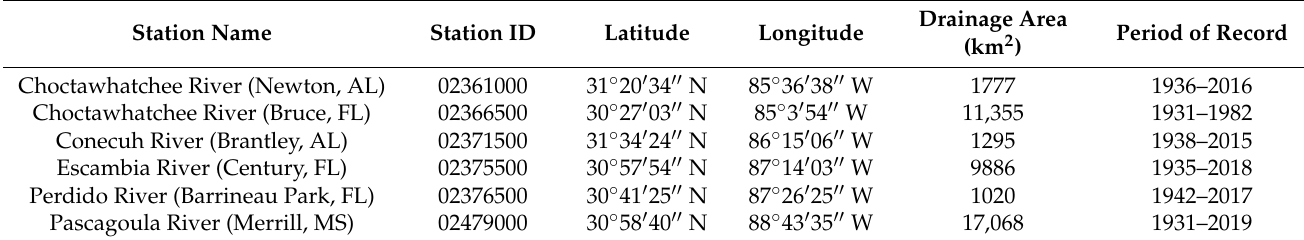
Table 1. Descriptions of the United States Geological Service (USGS) streamflow gages used for